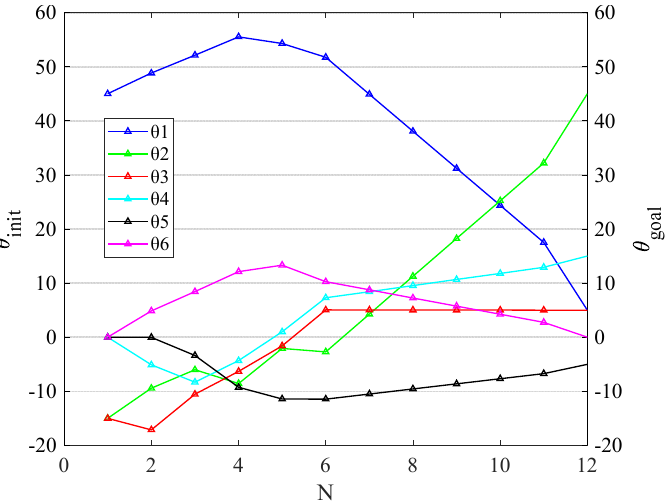
Figure 9. Exploration process of the main arm joint angle: ( a ) the first three joint angles of the main arm; ( b ) the posterior three joint angles of the main arm.